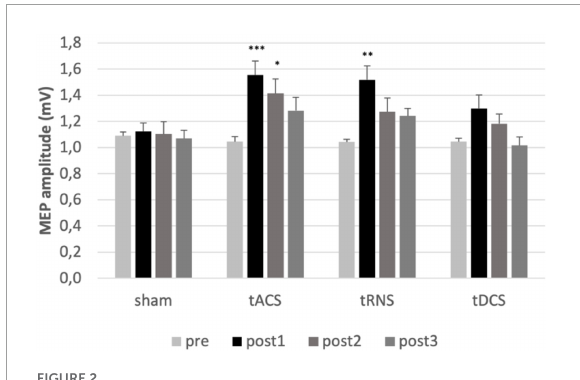
FIGURE2 Analysis of MEPs. MEPs mean values pre and post interventions are shown. Error bars representing the standard error of the mean. ∗ Represents a p -value < 0.05, ∗∗ represents p -value < 0.01 and ∗∗∗ p -value < 0.001 in Bonferroni-Holm-corrected t -test. Significant increase of MEP after tACS at post1 compared to pre ( p = 0.001) and post2 compared to pre ( p = 0.018). Significant increase of MEP after tRNS at post1 compared to pre ( p = 0.002). MEP, motor evoked potential; FDI, first dorsal interosseous muscles; tACS, transcranial alternating current stimulation; tDCS, transcranial direct current stimulation; tRNS, transcranial random noise stimulation. post1 = 15 min; post2 = 55 min; post3 = 95 min post